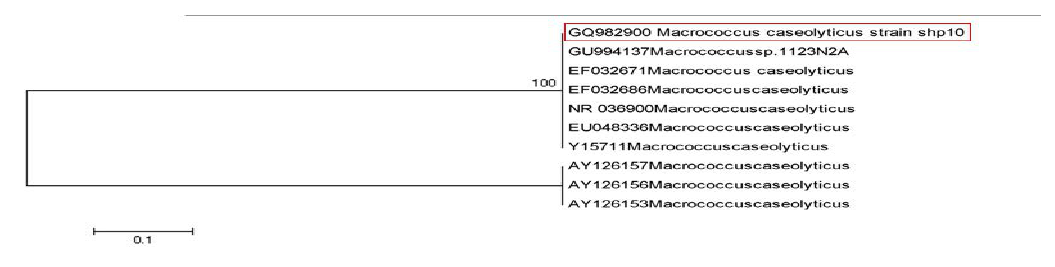
Fig. 3. Phylogenetic analysis of SAtC-1